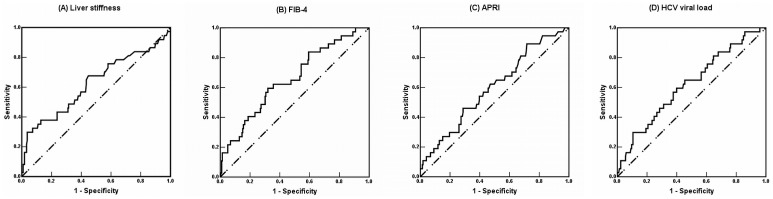
Receiver operating characteristic (ROC) curves using baseline liver stiffness (LS), fibrosis-4 (FIB-4) index, and the aspartate aminotransferase-to-platelet ratio index (APRI), and hepatitis C viral (HCV) load to dichotomize sustained virologic response (SVR) (no versus yes).According to the ROC analysis, the areas under curves were 0.624 (95% confidence interval, 0.514–0.733), 0.655 (0.560–0.751), 0.594 (0.496–0.692), and 0.618 (0.520–0.716) for baseline LS (A), the FIB-4 index (B), APRI (C), and HCV viral load (D), respectively, to dichotomize SVR (no versus yes). The comparison of the AUCs was not significant between the FIB-4 index and LS (P = 0.4231), between the APRI and LS (P = 0.4621), or between the HCV viral load and LS (P = 0.8104).